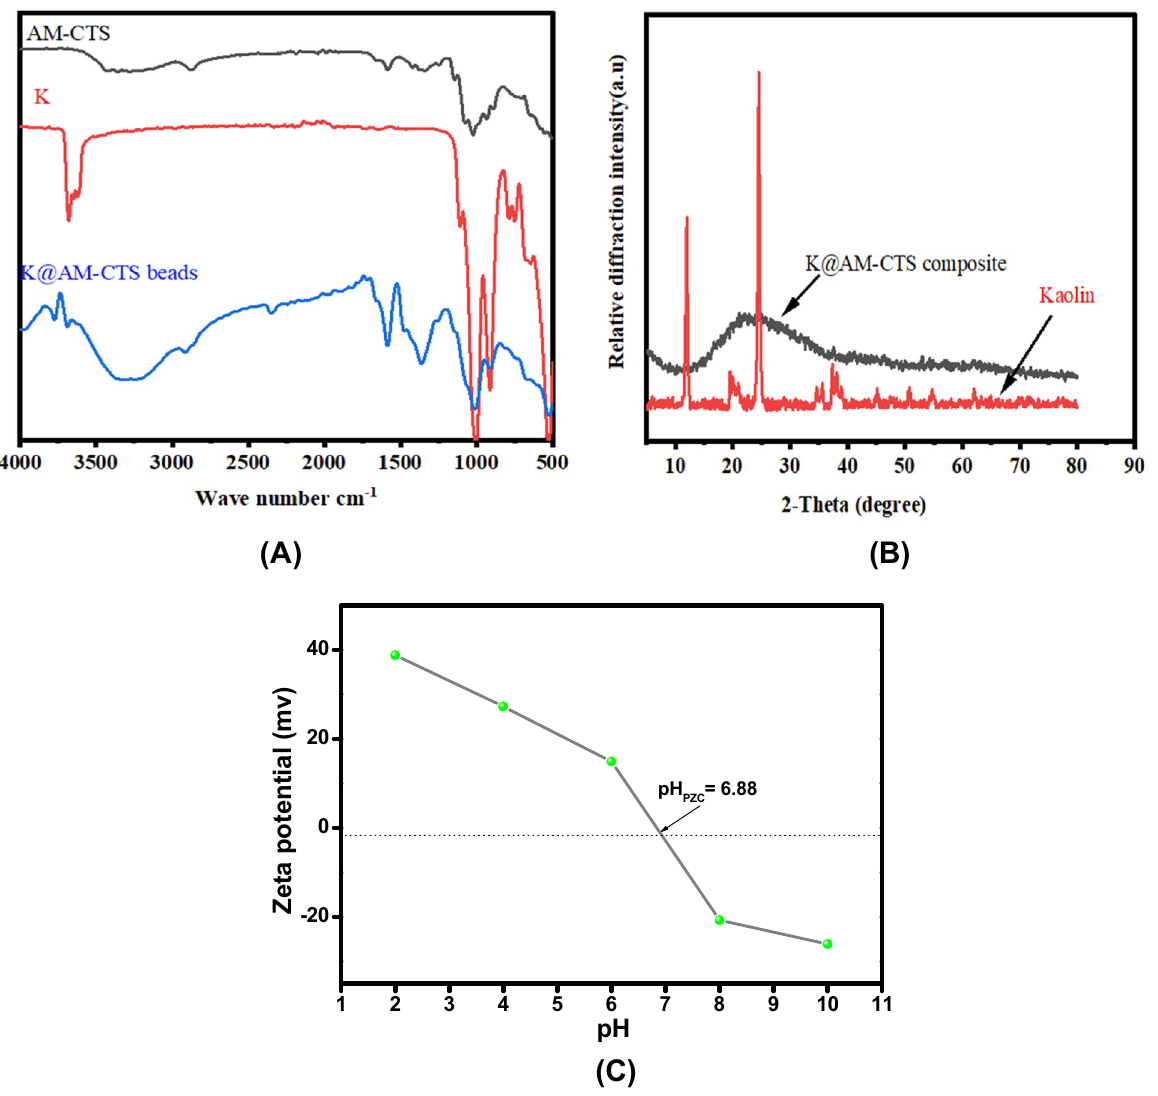
Figure 2. ( A ) FTIR of AM-CTS, kaolin and K@AM-CTS composite beads, ( B ) XRD patterns of kaolin and K@ AM-CTS composite beads and ( C ) Zeta potential profile of K@AM-CTS composite